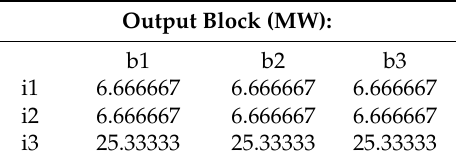
Table A2. The capacity of segment b of the cost curve of unit i (MW): g_max( i , b